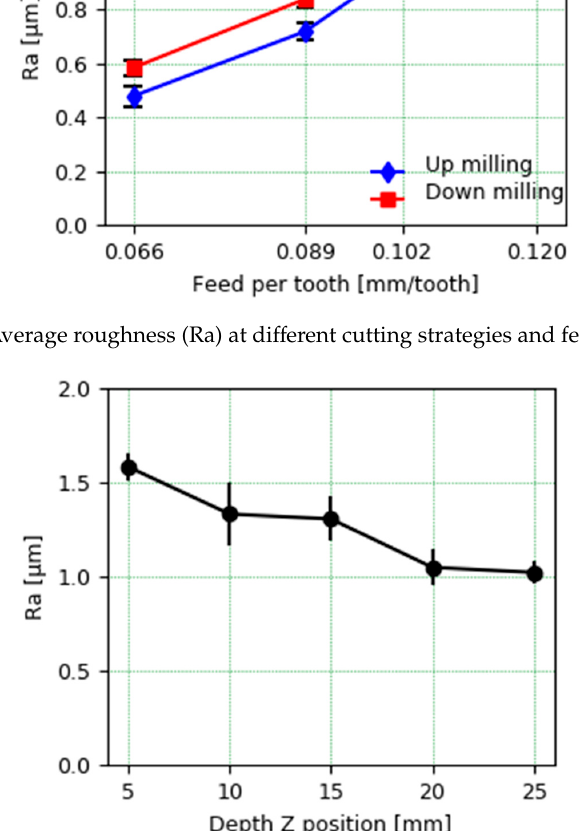
Figure 13. Average roughness (Ra) at different cutting strategies and feed per tooth.